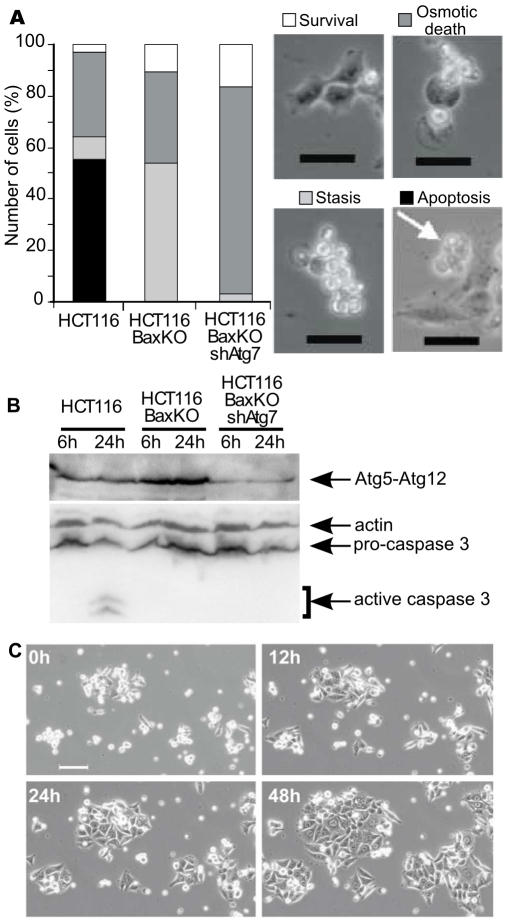
Starvation stimulates survival autophagy in HCT116 cells.(A) Morphometric analyses of cells starved for 48 hours. Cells were plated in complete media and time-lapse video microscopy was started upon transfer into HBSS. Viable cells are defined as adherent cells, apoptotic cells are defined as cells exhibiting multiple membrane blebs, death by loss of osmotic integrity is defined as cells displaying the swelling of a single bleb, and stasis cells are defined as cells that have detached from the substratum but maintain plasma membrane integrity. A minimum of 700 cells were analysed over triplicate experiments. Scale bar: 50 µm. (B) Western blots showing caspase 3 activation and Atg5-Atg12 conjugate in whole cells extracts from cells starved for the indicated times. (C) The non-adherent HCT116-BaxKO cells from 24 hours-starved cultures were collected and transferred into complete medium. Cells were allowed to adhere for 6 hours, then time-lapse video microscopy was started for 48 hours. Scale bar: 100 µm.